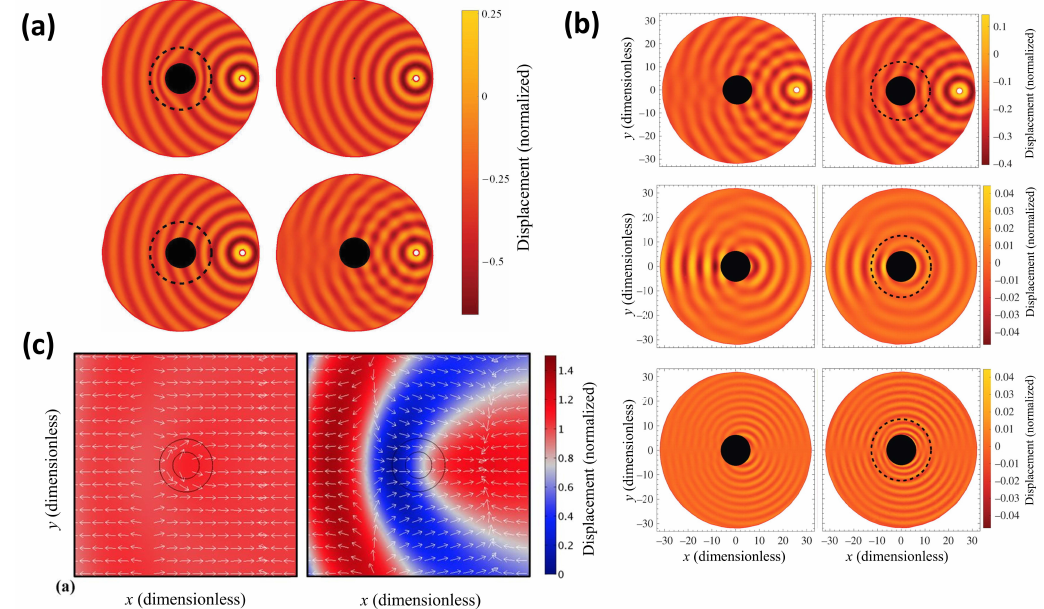
Figure 9. ( a ) Total displacement field of anti-plane shear waves. Line source is shown as a white circle. Left side: a classic elastic cloak (upper) and a designed pre-stress elastic cloak (lower). Right side: scattering from a cavity of radius k s R = π /20 (upper) and 2 π (lower) in an unstressed medium, where k s is the shear wavenumber of the medium and R is the annulus inner radius of the cavity; ( b ) Top: Total displacement field of SH waves without a cloak (left) and with a cloak (right). Center: Scattered displacement field of P waves without a cloak (left) and with a cloak (right). Bottom: Scattered displacement field of SV waves without a cloak (left) and with a cloak (right); ( c ) Displacement field distributions of cloaked (left) and uncloaked (right) rigid object. White arrows: vector direction. Colored contours: amplitude. ( a ) adapted from [108]. ( b ) adapted from [109]. ( c ) adapted from